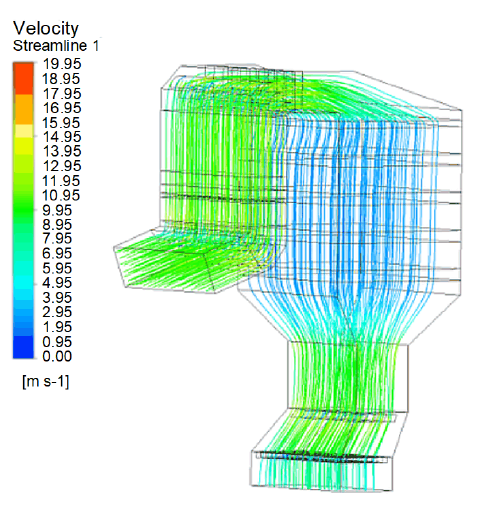
Figure 6. System streamline diagram with static mixer 1.